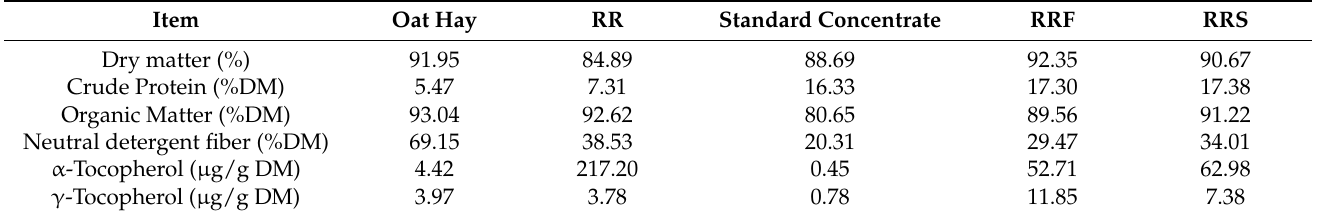
Table 1. Chemical composition of diets fed to Barbarine